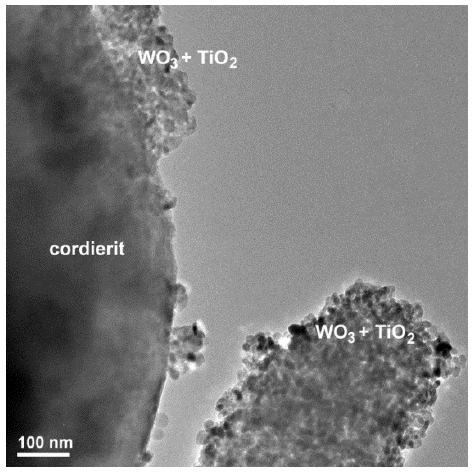
Figure 6. BF-TEM image of hydrodynamic cavitation processed catalyst sample.